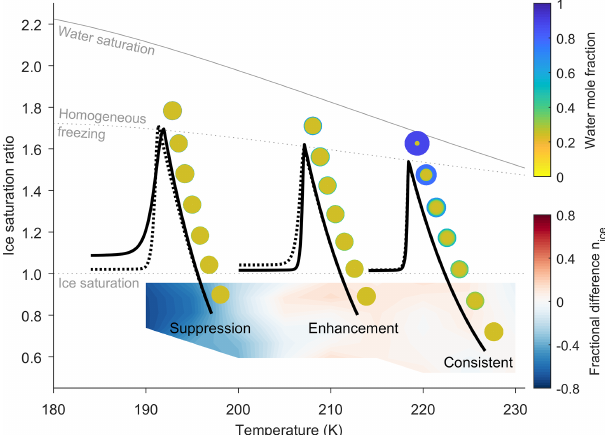
Figure 4. A schematic showing the effect of initial temperature on particle composition, ice formation and ice saturation ratio, high- lighting the effects of temperature-dependant diffusion on ice nu- cleation for three specific cloud parcel trajectories. The solid black lines show a cloud parcel trajectory for our new model and the bro- ken black line for the control simulation. The changing water mole fraction for a single particle is shown next to each of the parcel tra- jectories. The fractional difference in number of frozen particles is shown at the initial conditions of ice saturation ratio and temper- ature, where the blue areas show that ice formation is suppressed in the new model simulations in comparison to the control model, and red regions show an enhancement in the number of frozen par- ticles in new model simulations. At the lowest temperatures, be- low 200K water molecules are immobile and particle growth is restricted, leading to a suppression in ice formation. As tempera- ture increases, water molecules become more mobile and diffuse through the viscous SOA particle, so that between 200 and 220K there is an increase in the number of particles frozen as a result of the thicker layer of water on the aerosol surface. At higher temper- atures, above 220K an aerosol core is still visible, however the core shrinks in relation to the outer liquid water layer until the aerosol particle is almost totally mixed as the parcel reaches the conditions for homogeneous freezing, which results in a consistent number of particles freezing in both the new and control model. Simulations from both the new and control model have been initiated with a size distribution 3, given in Fig. 2, under a constant updraft velocity of 0.6ms − 1